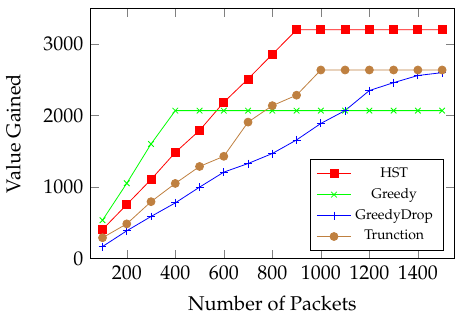
Figure 5. Online MTEF: comparison between HST, Greedy, GreedyDrop and Truncation on FIFO